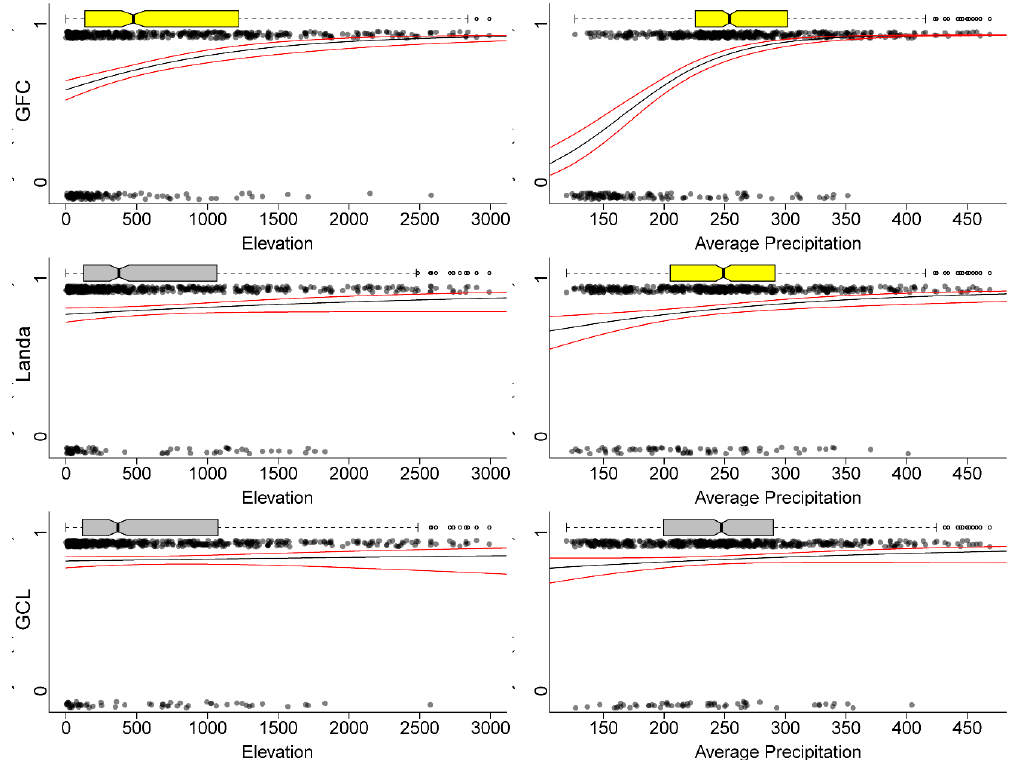
Figure 7. Univariate logistic regressions showing the likelihood of forest reference points being classified as forest (1) or non-forest (0) along gradients of elevation (left) and precipitation (right). Each panel row shows a different map product classification (GFC, Landa, and GCL). Each point is a classified pixel that is known to be forest cover in the reference data (>89% tree cover). The black lines are the predicted classification probabilities of forest (1) and non-forest (0) from each logistic regression, with red lines representing confidence intervals. The box plots show the distribution of correct and incorrect forest predictions along relevant gradients. Significant effects in the multiple logistic regression (see text, Table A4) are highlighted by yellow boxplots.